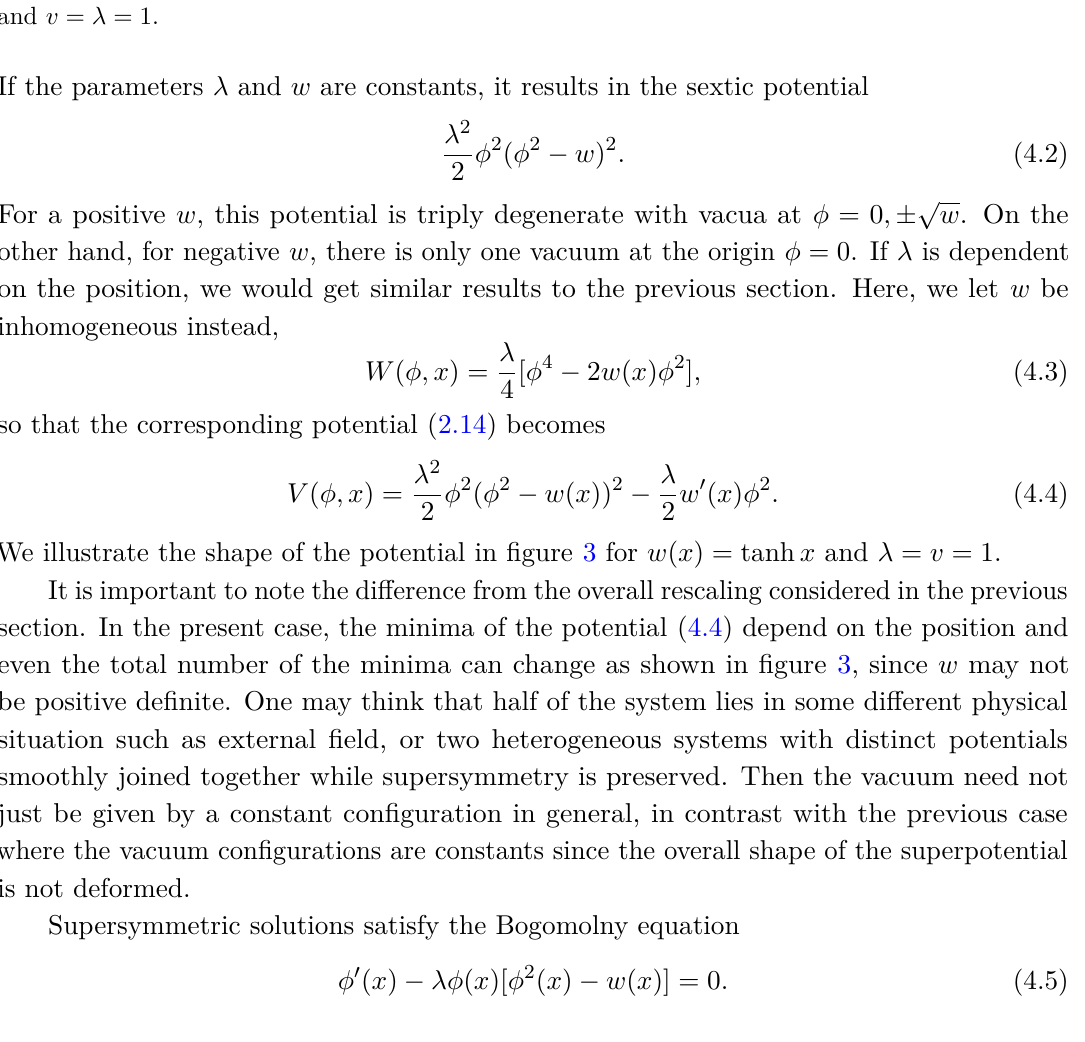
Figure 3 . An example of the inhomogeneous potential V ( φ, x ) in (4.4) with w ( x ) = tanh x and v = λ = 1